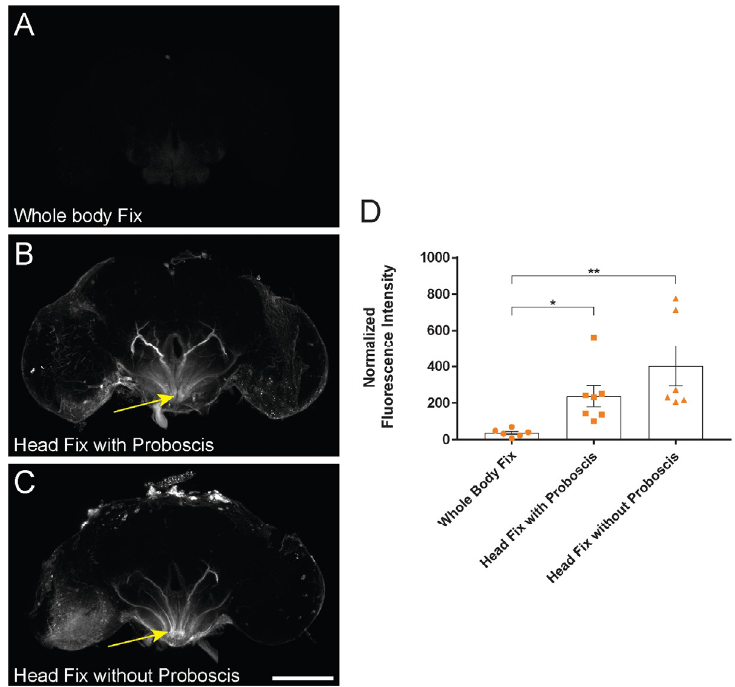
Figure 2. Whole-body pre-fixation reduces baseline dye infiltration. ( A – C ) Representative maximum projection laser-scanning confocal images of whole-mount brains from d10 w 1118 females injected with 10 kDa TMRD on d9. Baseline TMRD infiltration in: ( A ) whole-body pre-fixation, ( B ) head pre-fixation with proboscis attached, and ( C ) head pre-fixation without proboscis. TMRD infiltration into the subesophageal zone (SEZ) was noted in both head pre-fixation conditions (arrows in ( B , C )). ( D ) Quantification of normalized TMRD fluorescence infiltration across fixation conditions using nc82/TMRD intersection binary analysis. * p < 0.05; ** p < 0.01; Kruskal–Wallis test with Dunn’s multiple comparisons; n = 6–7; error bars are presented as mean ± SEM. Scale bar = 100 µm. Maximum projection images were generated from the middle ~75 µm region of the brain to highlight SEZ infiltration.